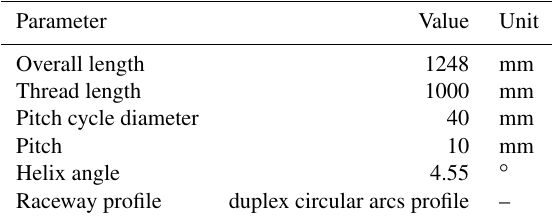
Table 2. Parameters of tested ball